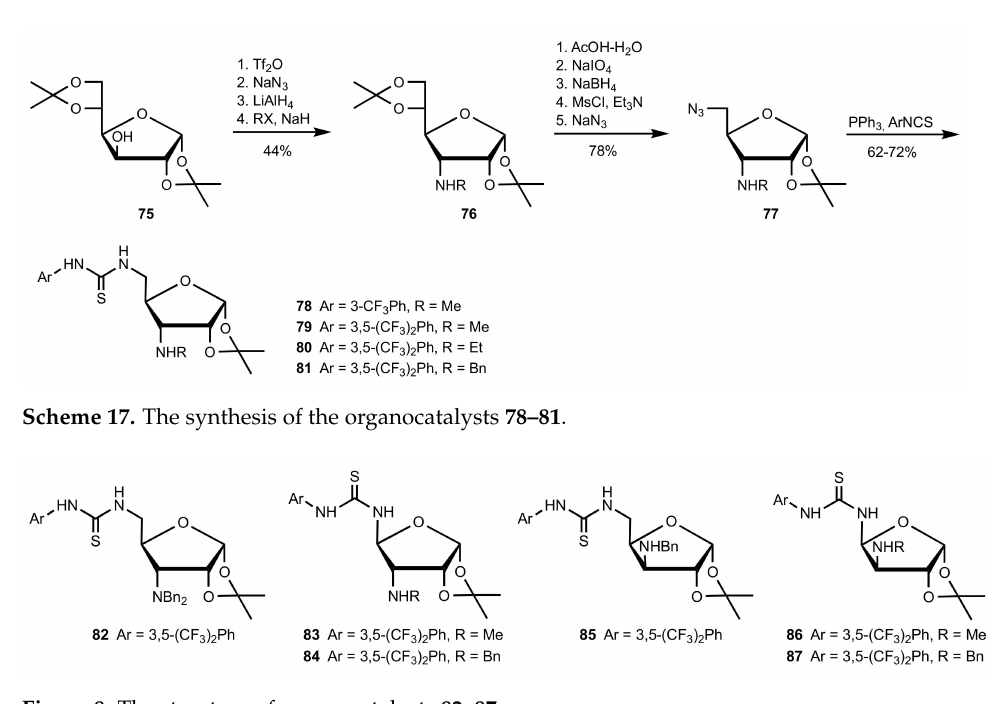
Figure 8. The structure of organocatalysts 82–87